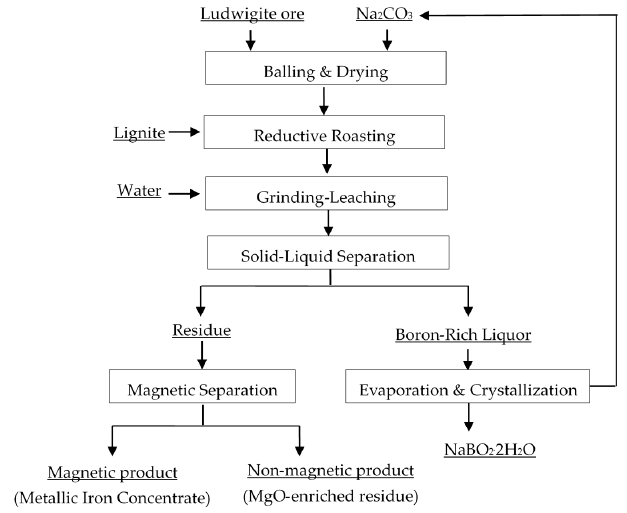
Figure 1. Process for extracting iron and boron from ludwigite ore [27].